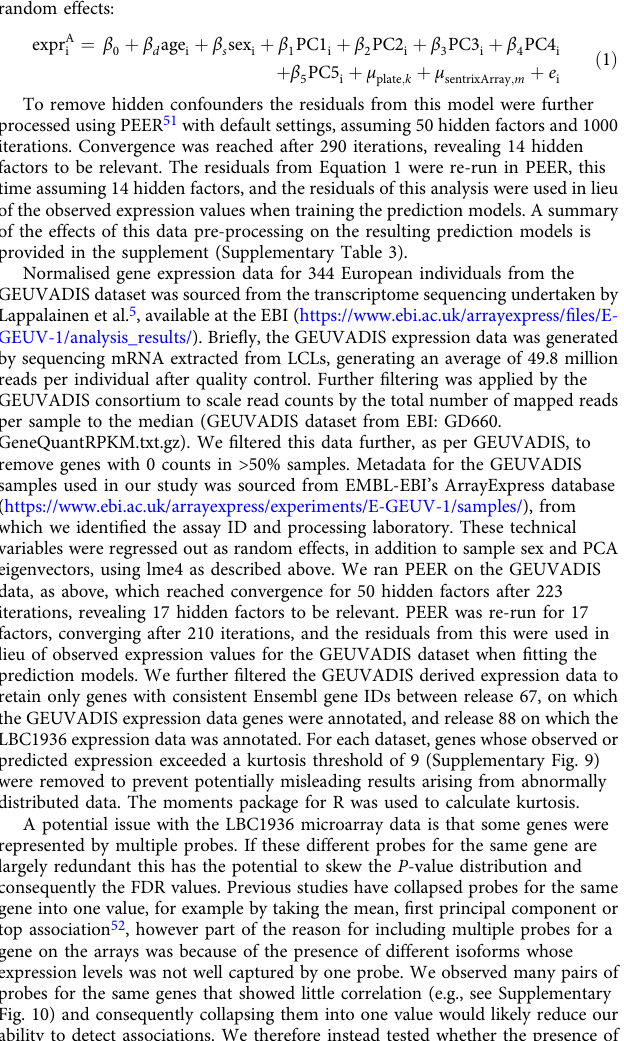
sex, age, population structure covariates and technical variation by fi tting sex, age, and the fi rst fi ve eigenvectors resulting from PCA of the genotype data in Plink (Supplementary Fig. 8) as fi xed effects, and sample plate and Sentrix array as random